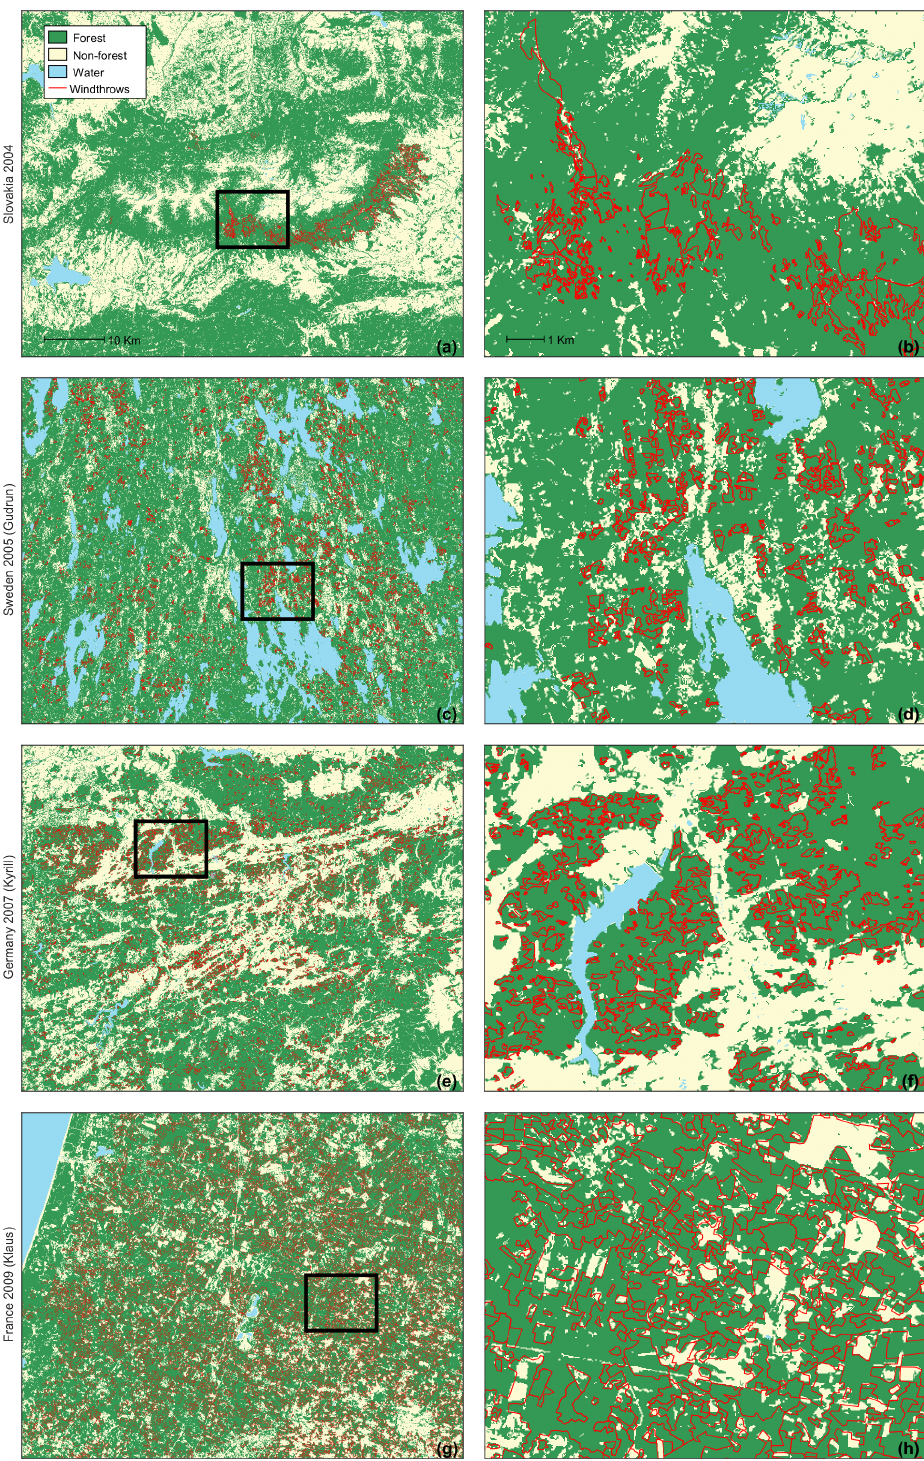
Figure 2. Examples of wind disturbances recorded in the FORWIND database. (a, b) Tatra Mountains, Slovakia, affected by a windstorm in 2004. (c, d) Southern Sweden, affected by windstorm Gudrun in 2005. (e, f) Western Germany, affected by windstorm Kyrill in 2007. (g, h) Western France, affected by windstorm Klaus in 2009. Wind disturbances recorded in the FORWIND database are shown as red polygons. Background colours show forest and non-forest areas derived from the 25m forest cover map from 2000 (Pekkarinen et al., 2009), while water bodies are derived from the 25m land cover type map from 2006 (Kempeneers et al., 2011) (https://forest.jrc.ec.europa.eu/en/ past-activities/forest-mapping/#Downloadforestmaps, last access: 20 December 2019). Site locations in (a, c, e, g) are shown in Fig. 1a, whereas the zoomed plots in (b, d, f, h) refer to black boxes in (a, c, e, g)